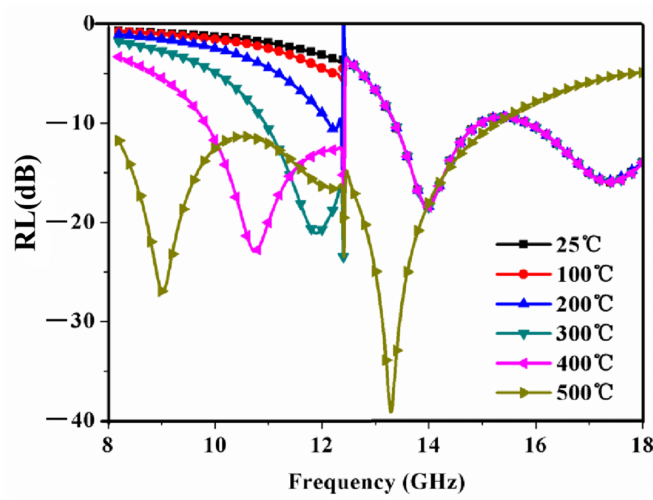
Figure 8. Optimized reflection loss results of RAM versus frequency for different temperature.